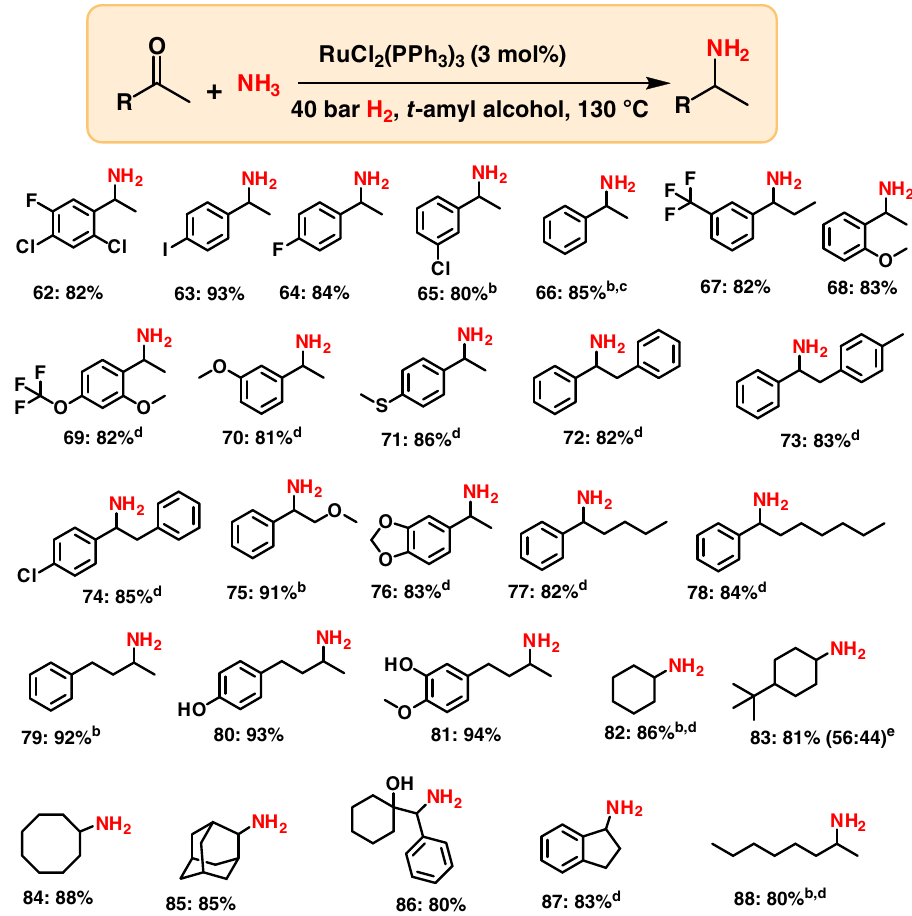
Fig. 3 RuCl 2 (PPh 3 ) 3 -catalyzed synthesis of branched primary amines from ketones. a Reaction conditions: 0.5 mmol ketone, 3 mol% RuCl 2 (PPh 3 ) 3 , 5 – 7 bar NH 3 , 40 bar H 2 1.5 mL t -amyl alcohol, 130 o C, 24 h, isolated yields. b GC yields using n-hexadecane as standard. c Same as ‘ a ’ with 1 mol% catalyst. d Same as ‘ a ’ for 30 h. e Diastereomeric ratio. Isolated as free amines and converted to hydrochloride salts. Corresponding hydrochloride salts were subjected to NMR